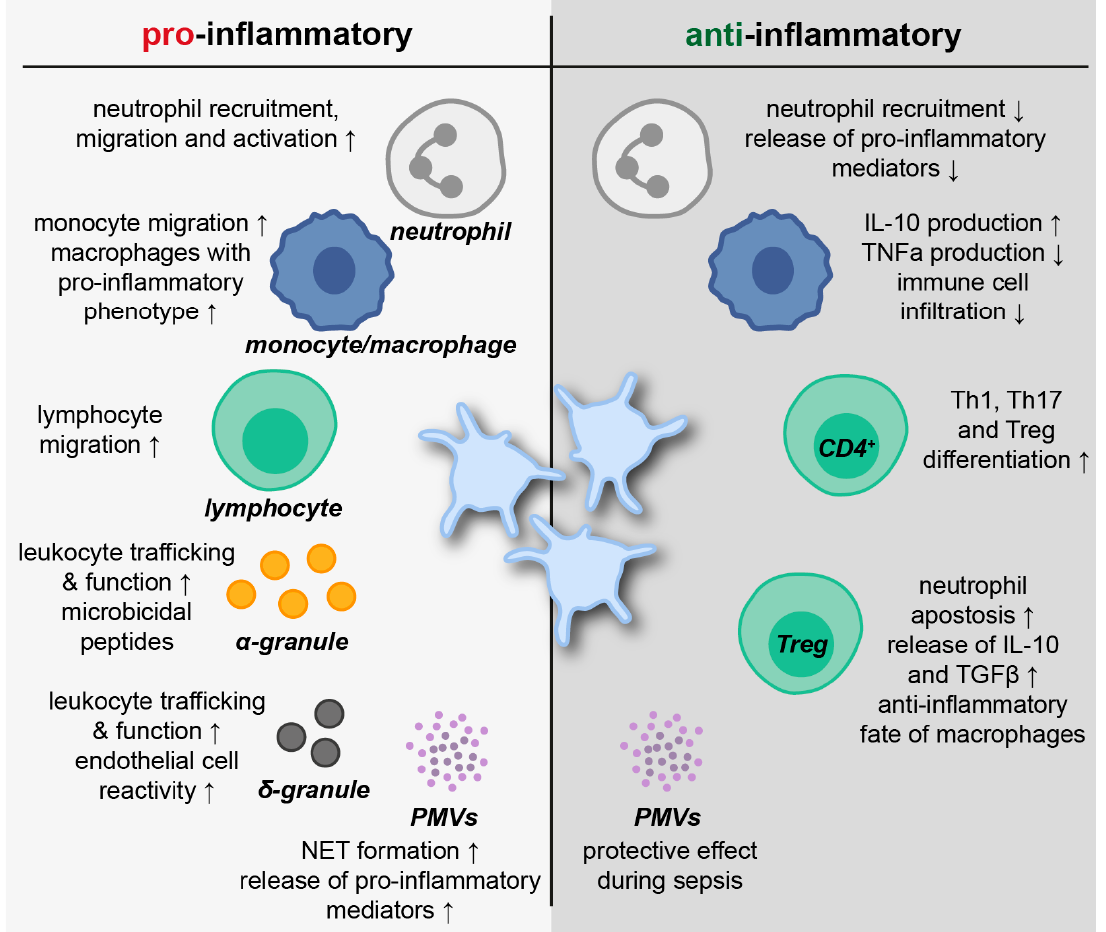
Figure 2. Platelet-leukocyte interactions in pro- and anti-inflammatory processes. The interaction of platelets with leukocytes via direct cell–cell contact and soluble mediators affects the immune response in multiple ways. PMVs = platelet-derived microvesicles; TNF α = tumor necrosis factor α ; TGF β = transforming growth factor β ; Th = T helper cell; Treg = regulatory T cell.